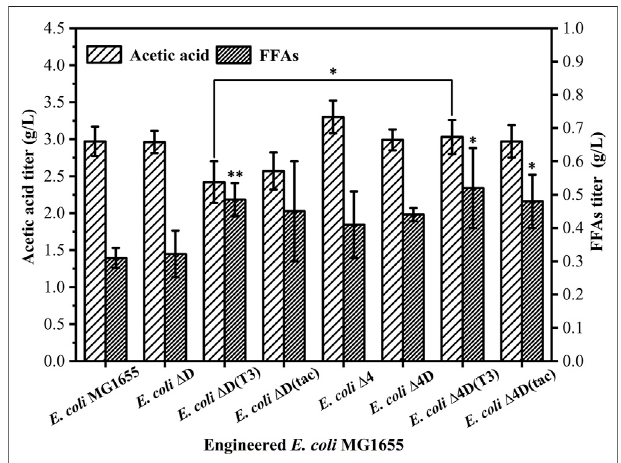
FIGURE 2 | Comparison of the ability of engineered E. coli to produce acetic acid and FFAs in shake fl asks, and the cultivation time was 60 h. The error bars indicate the standard deviation of triplicate experiments. * p < 0.05; ** p < 0.01; *** p < 0.001; ns, no signi fi